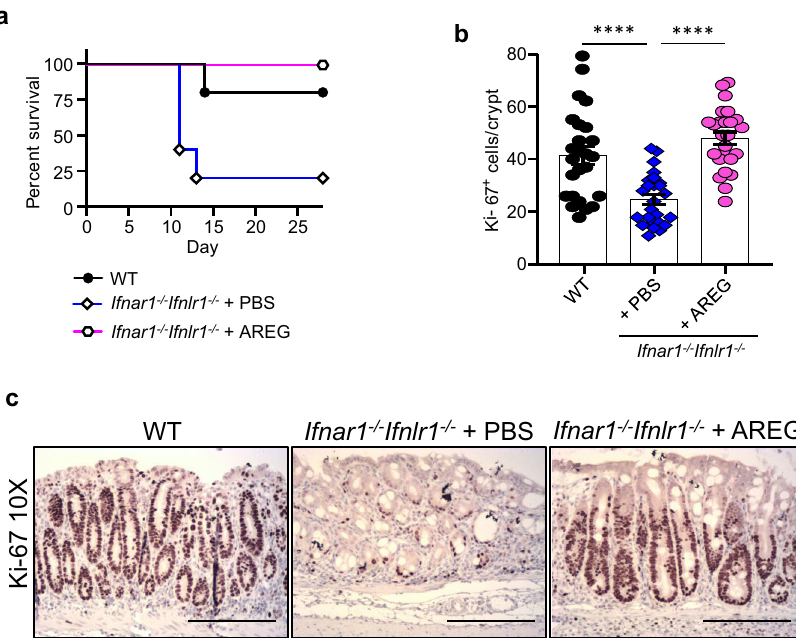
Fig. 7 Administration of AREG rescues Ifnar1 − / − Ifnlr1 − / − mice from experimental DSS-induced colitis and restores colonic regeneration. a – c 6 – 8- week-old WT and Ifnar1 − / − Ifnlr1 − / − were exposed to 1.5% DSS in drinking water for 7 days, followed by regular water. On days 5, 7, 9, and 11, Ifnar1 − / − Ifnlr1 − / − mice were administered AREG (5.0 μ g) or PBS as a control by IP injection, and the animals were monitored daily for survival ( a ) ( n = 5). b , c On day 11, mice were euthanized ( n = 5) and proliferation of epithelial cells in the colon was evaluated by IHC staining for Ki-67. Symbols in b represent the number of Ki-67 + cells per crypt ( fi ve crypt/slide/animal; n = 5). c Representative images. Scale bars are 100 μ M. Data are representative of two independent experiments. Quantitative data were analyzed using one-way ANOVA followed by Bonferroni ’ s multiple comparisons test and represent mean values with SEM. **** P ≤